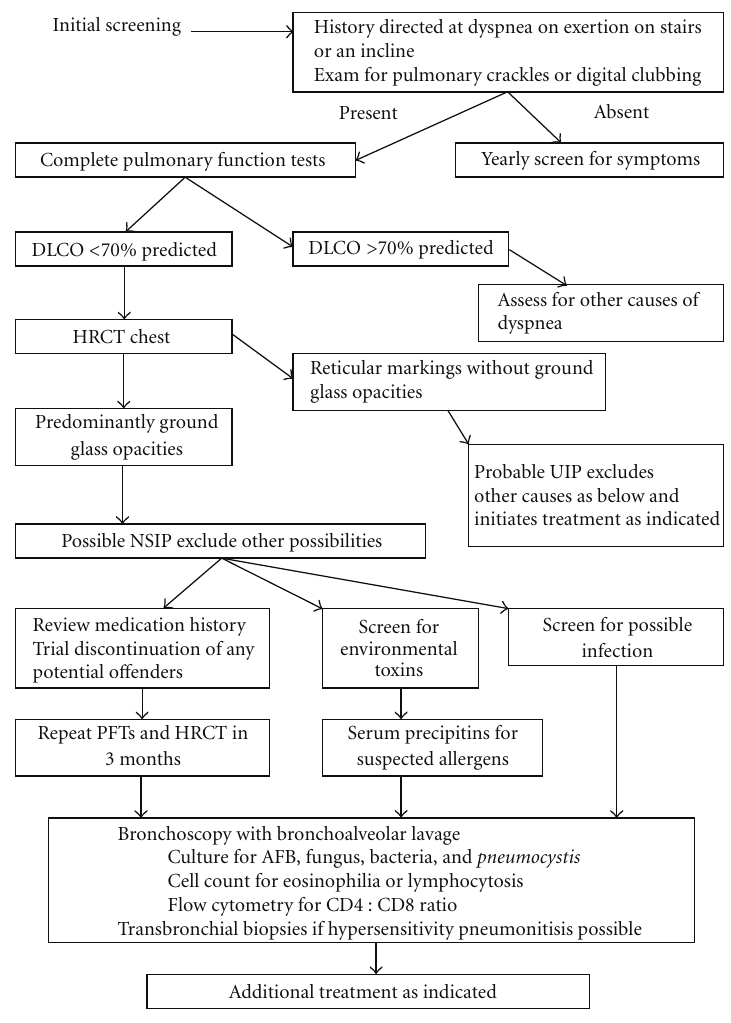
Figure 2: Diagnostic algorithm for the evaluation of rheumatoid